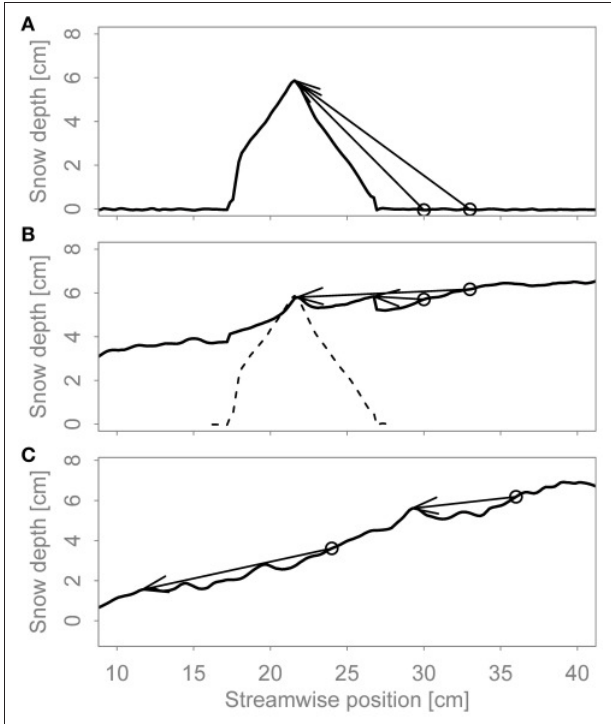
FIGURE 7 | Relative Kinect snow depth profiles and arrows showing some examples of shelter-giving points. The circles show the SMP positions. The wind is from left to right. (A) Initial conditions of an experiment with an obstacle and two highly wind-sheltered SMP positions. (B) Same experiment as in (A) but after deposition of snow around the obstacle. The same SMP positions are now not wind-sheltered anymore. The dashed line outlines the obstacle. (C) Two examples of wind-exposed SMP positions during an experiment without an obstacle.